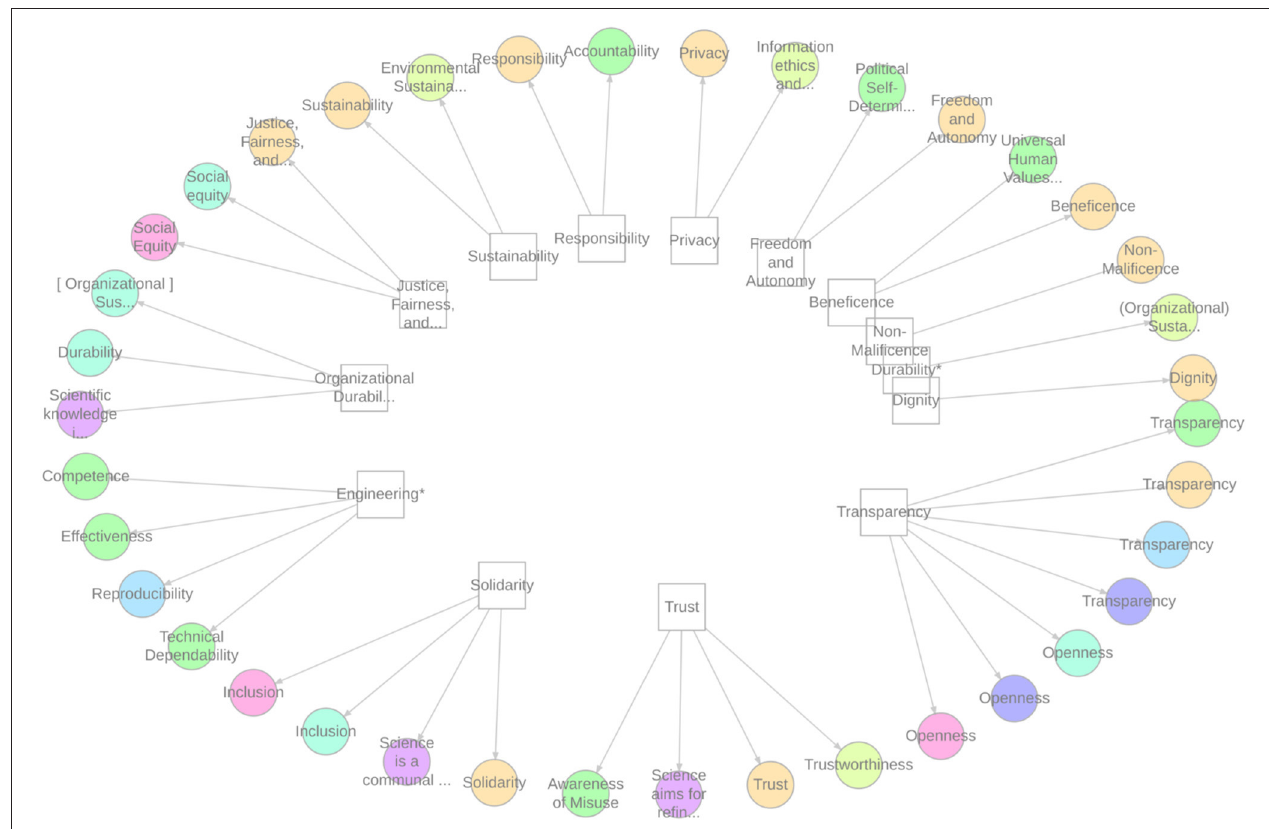
FIGURE 1 | Relationship among values. *Denotes an extension to the core categorization developed in Jobin et al.